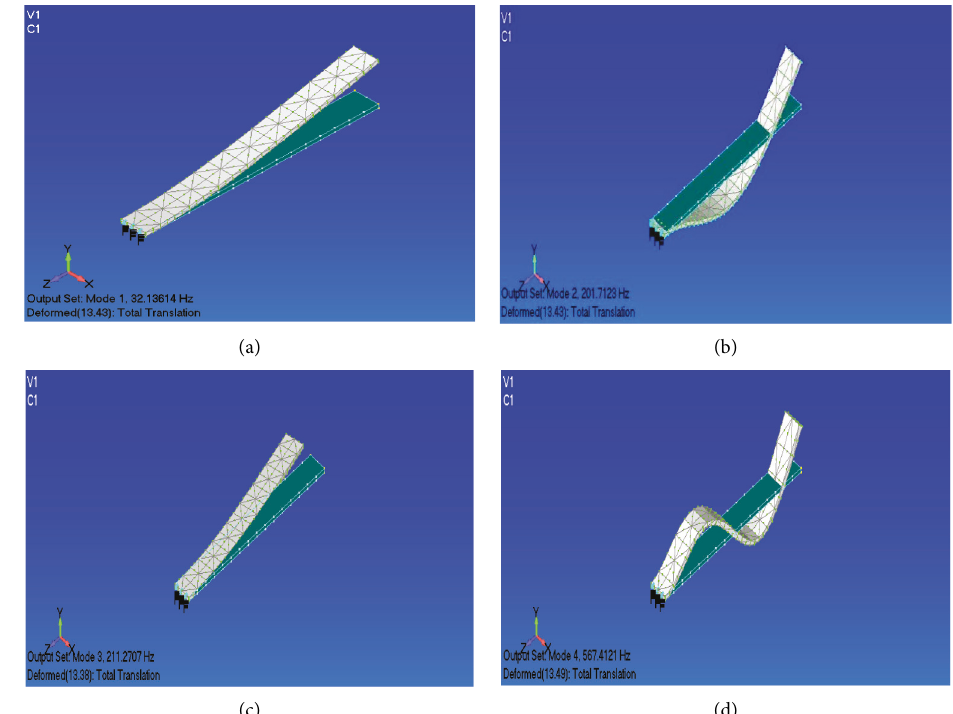
Figure 11: Vibration analysis of 50/50% glass/epoxy composite plate. (a) Mode 1, (b) Mode 2, (c) Mode 3, (d) Mode